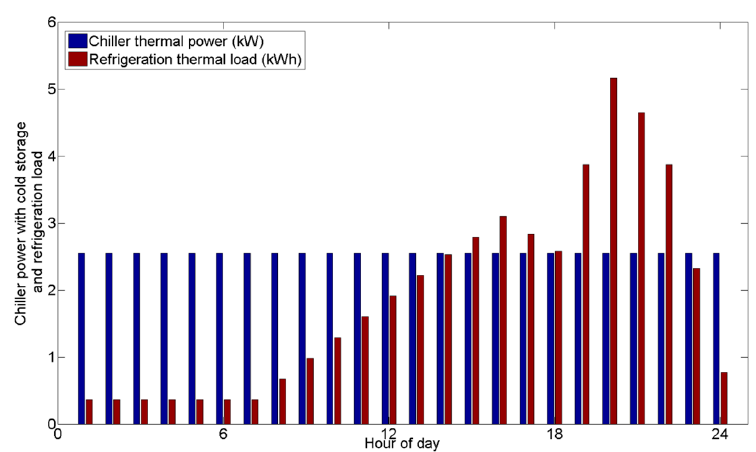
Figure 6. Chiller power with cold storage.